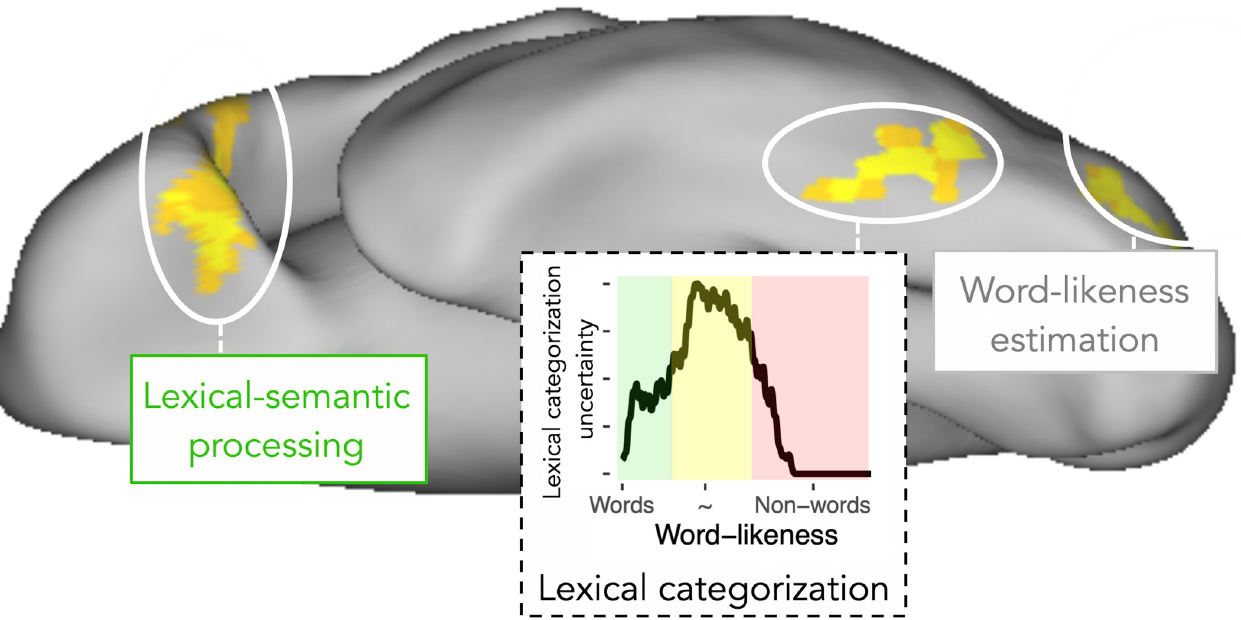
Fig 7. Schematic description of processes during visual word recognition as assumed in the lexical categorization model . The figure includes (i) word- likeness estimations in posterior visual-perceptual regions, (ii) lexical categorization in the left ventral occipito-temporal cortex (lvOT), and (iii) the extraction of word meaning in anterior regions including temporal and inferior frontal cortex. The lexical categorization process implemented in lvOT is schematically represented by the uncertainty (entropy), to visualize the LCM’s assumption that higher degrees of categorization uncertainty–in sections of intermediate word-likeness (yellow)–may require further elaborative processing to reach a lexical categorization.